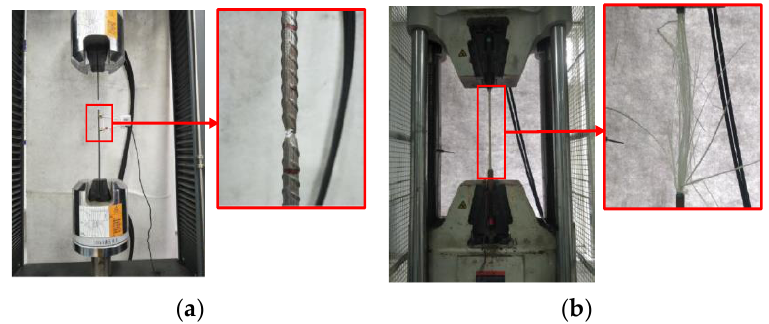
Figure 2. Tensile tests for steel and GFRP bars. ( a ) Steel bars; ( b ) GFRP bars. Table 4. Material properties of GFRP bars.